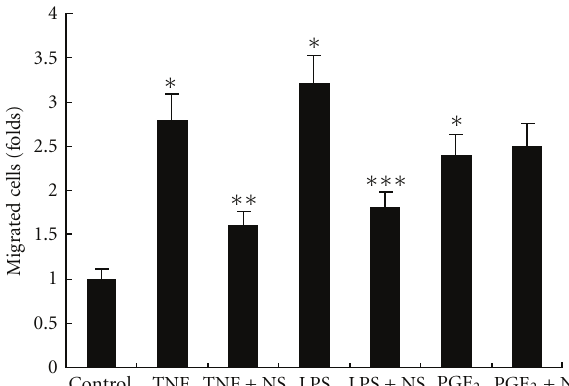
Figure 7: Migration analysis. Migration of BxPC-3 cells was increased after treatment with TNF- α ( ∗ P < 0 . 001, versus control), LPS ( ∗ P < 0 . 001, versus control), or PGE 2 ( ∗ P < 0 . 001, versus control). The increase caused by TNF- α or LPS was inhibited remarkably when NS398 was added ( ∗∗ P < 0 . 01, versus TNF; ∗∗∗ P < 0 . 01, versus LPS). Data are expressed as mean ± SD, n = 3. NS: